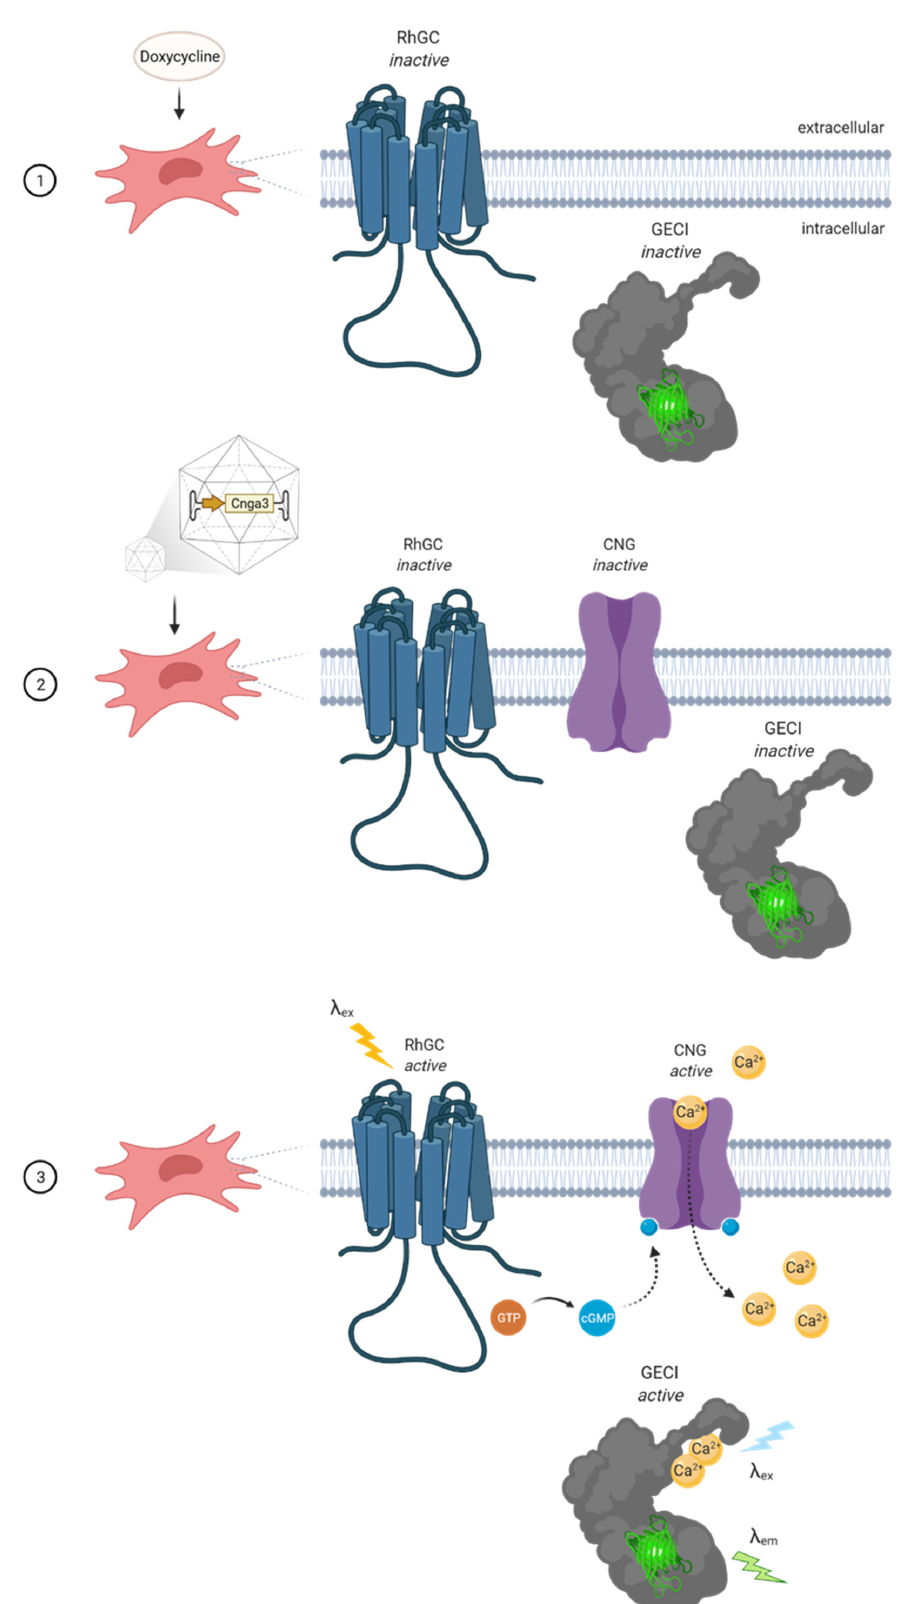
Figure 1. Schematic diagram showing the stepwise activation of the bioengineered cell system where (1) doxycycline induces the expression of rhodopsin guanylyl cyclase (RhGC) and genetically encoded calcium indicator (GECI) that remain inactive. (2) Transduction of the cells with AAV/CNGA3